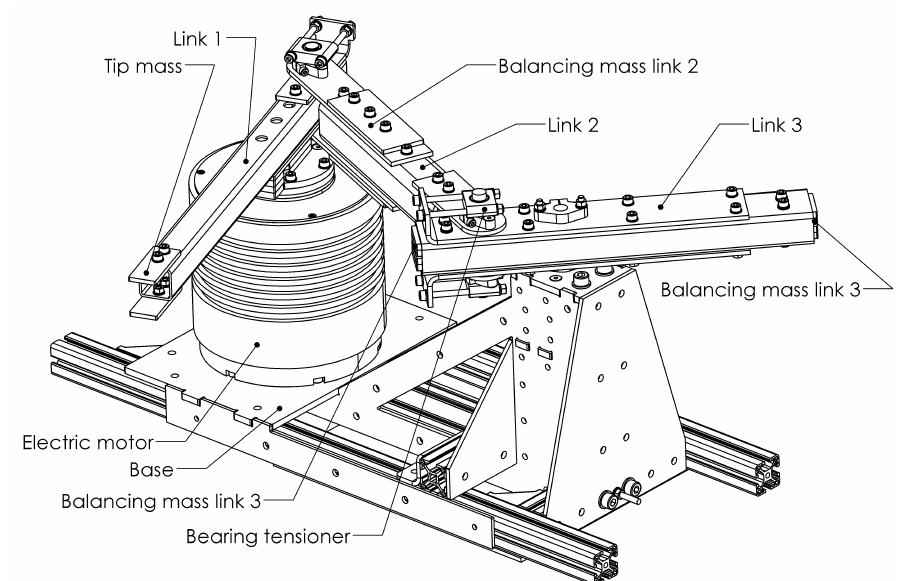
Figure 3. Final design of the dynamically balanced manipulator arm link 1 mounted on the electric motor and on the base.